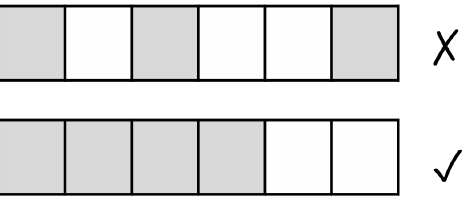
Figure 5. Continuous pixel marking (on the bottom) [edge